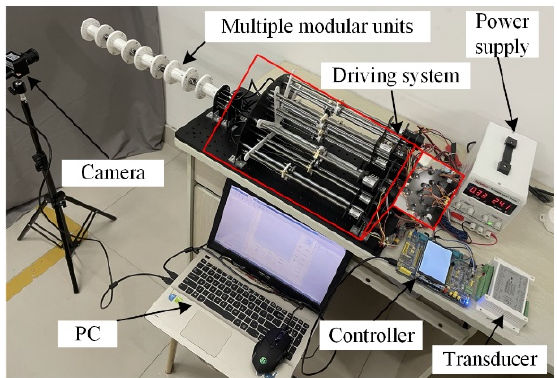
Figure 8. Variable-stiffness cable-driven manipulator system.